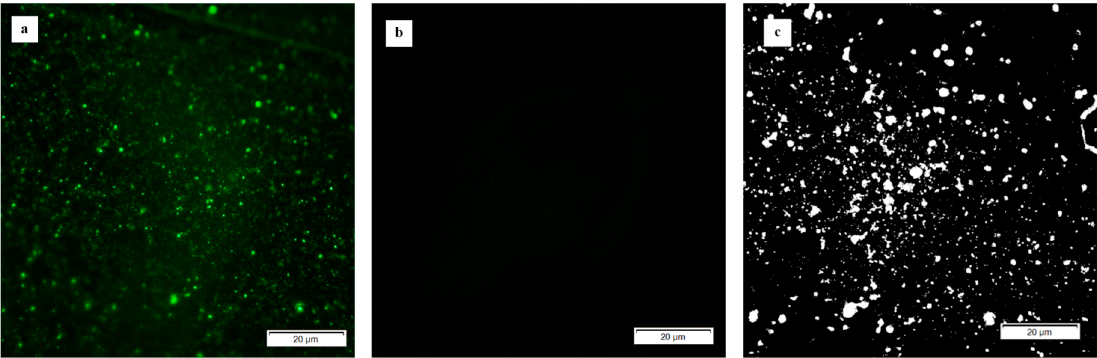
Figure 1. Fluorescence micrographs: ( a ) phage-coated sensor, ( b ) control sensor, and ( c ) binary